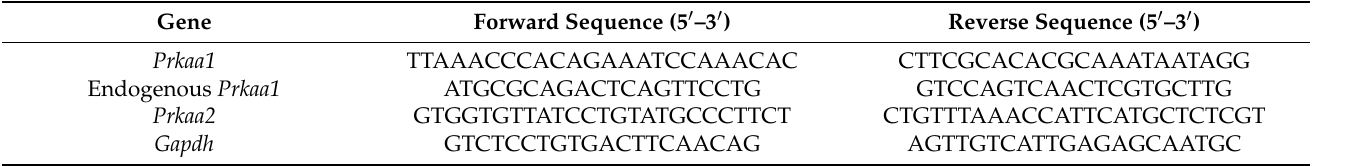
Table 1. RT-qPCR primer